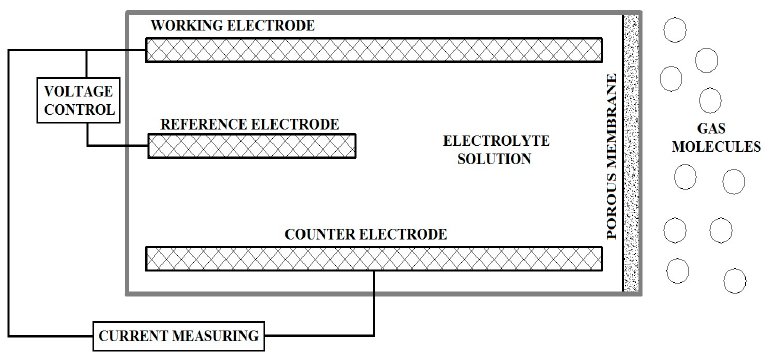
Figure 2. Scheme of electrochemical sensor in a three-electrode version with the measurement electrode, counter electrode and reference electrode.